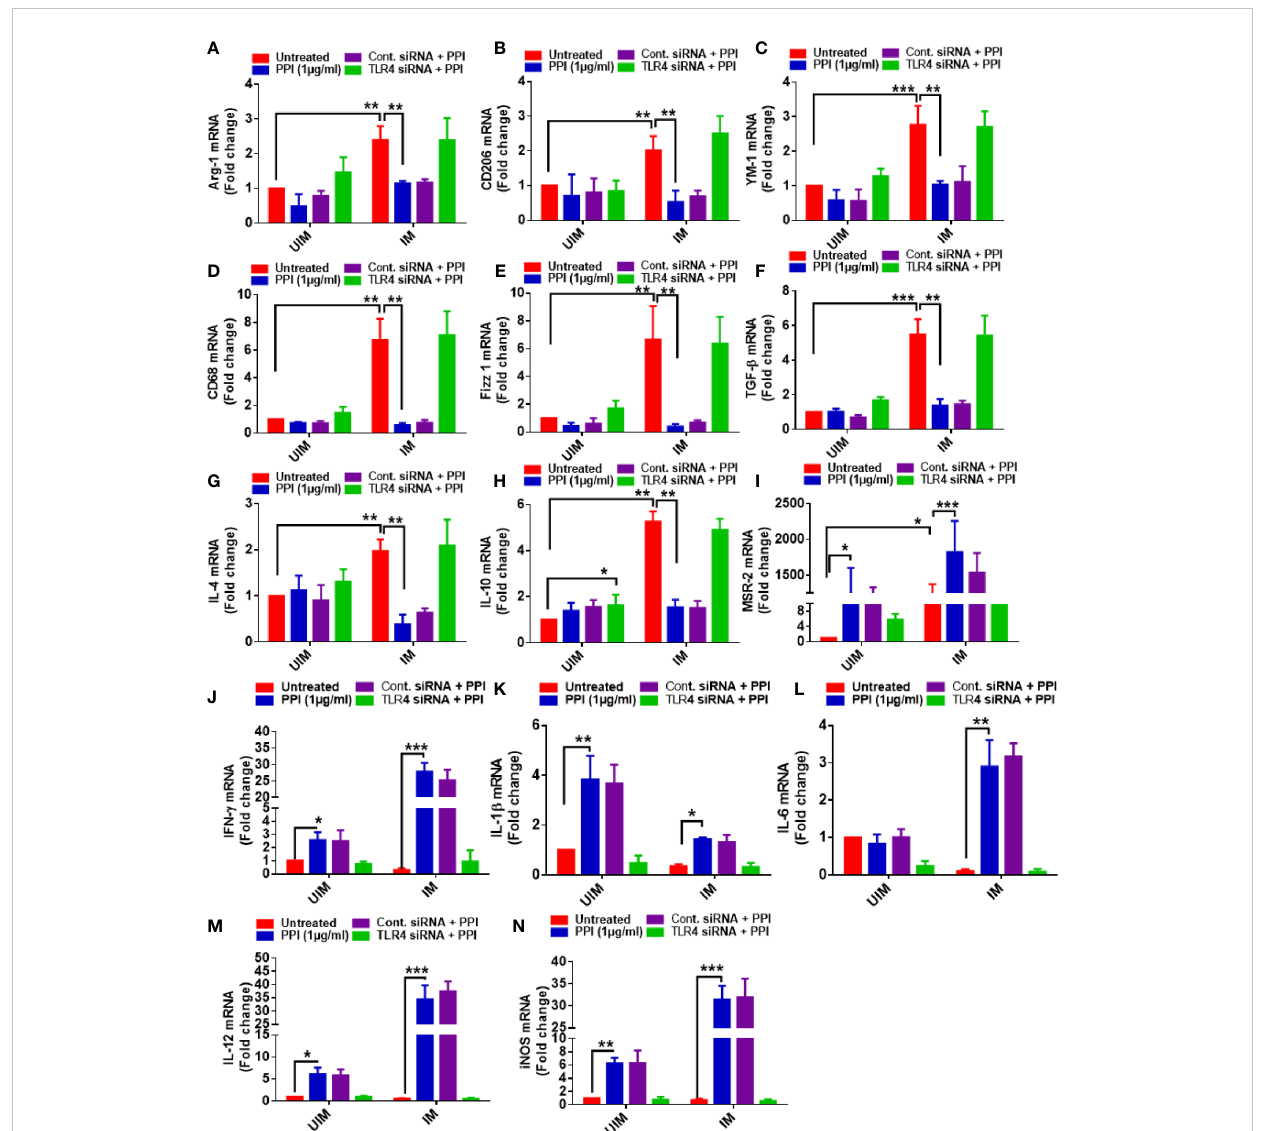
FIGURE 3 TLR4-dependent alteration of the mRNA expression of M1 – M2 markers in L. donovani -infected macrophages. The macrophages were cultured and transfected with TLR-4 siRNA. They were infected with stationary-phase L. donovani promastigotes in a 1:10 (macrophage/parasite) ratio, and after 4 h, the non-ingested parasites were removed by washing with sterile PBS. After 24 h of infection, macrophages were treated with or without the protein protease inhibitor (PPI). The macrophages were collected in Trizol. The mRNA expression of M1 [arg-1 (A) , CD206 (B) , YM-1 (C) , CD68 (D) , Fizz-1 (E) , TGF- b (F) , IL-4 (G) , IL-10 (H) , MSR-2 (I) ] and M2 [IFN- g (J) , IL-1 b (K) , IL-6 (L) , IL-12 (M) , iNOS (N) ] markers was determined in triplicate using real-time PCR. All the experiments were repeated at least two times, and data from one representative experiment were shown here as mean ± SD of relative fold change compared with the uninfected control. The asterisks indicate a signi fi cant difference upon comparing the respective PPI-untreated and the PPI-treated groups. * p ≤ 0.05, ** p ≤ 0.01, and *** p ≤